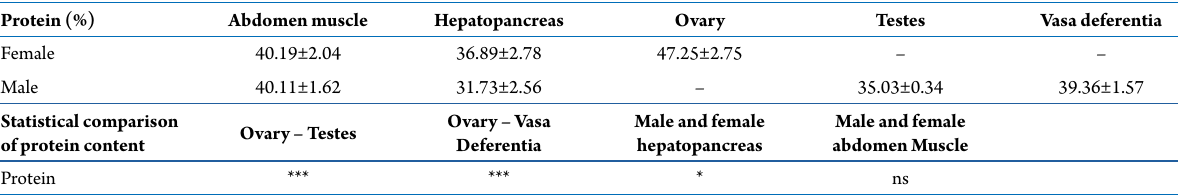
Table 1. Protein content (%, wet weight) of abdomen muscle, hepatopancreas and gonads during the reproductive season in male and female Pontastacus leptodactylus and statistical comparison of protein content in the ovary and testes, ovary and vasa deferentia, hepatopancreas and abdomen muscle between male and female of P. leptodactylus